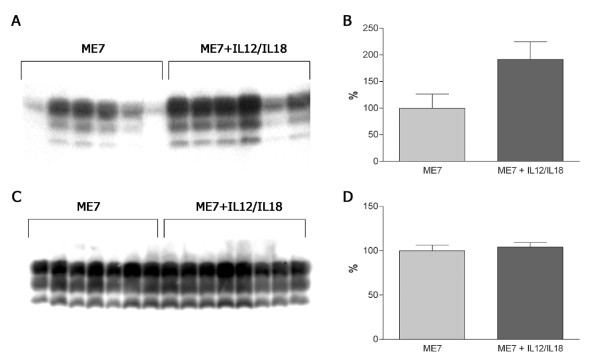
PrPsc evaluation. Western-blot patterns (A, C) and semiquantitative analysis (B, D) of brain homogenates of mice sacrificed at 90 days after infection (A, B) or terminally sick (C, D).